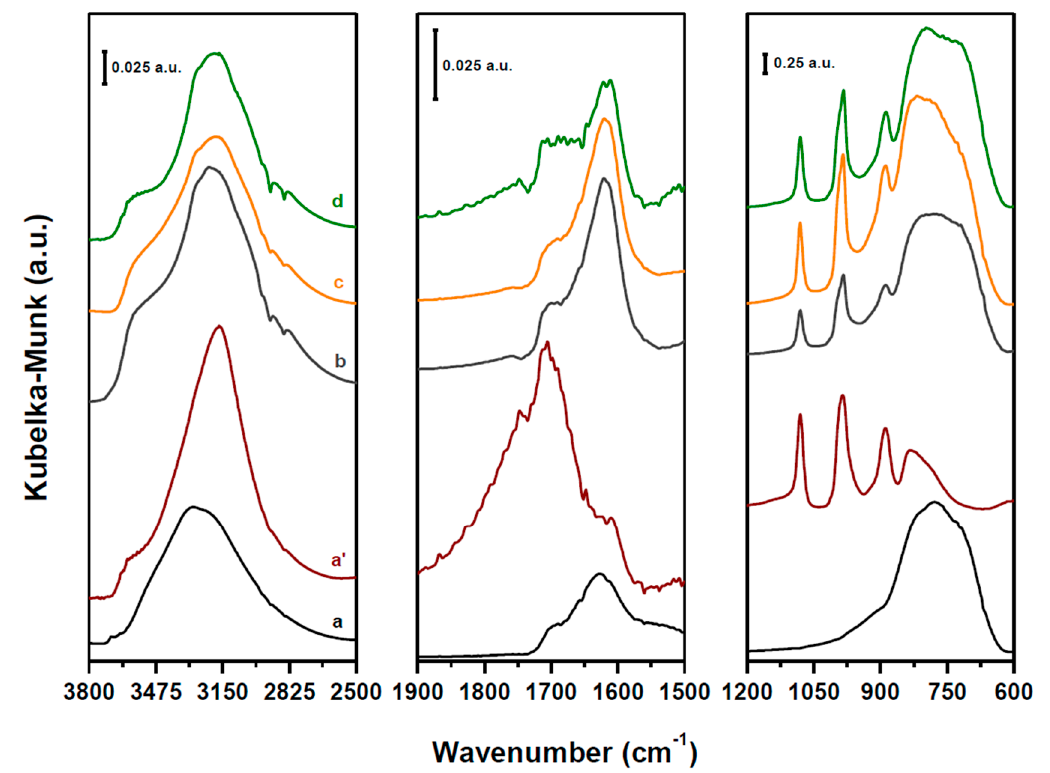
Figure 2. DRIFT spectra at room temperature of TiO 2 support (a), bulk HPW (a’) and xHPW / Ti acid catalysts: 1.4HPW / Ti (b), 1.7HPW / Ti (c) and 2.7HPW / Ti (d).